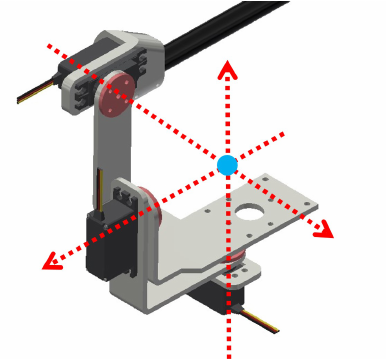
Figure 6. The coordinate system of the K-handler.